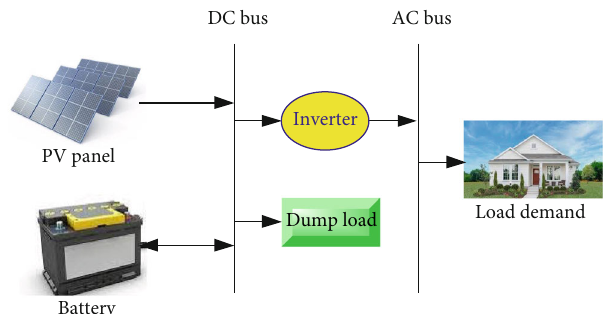
Figure 1: Stand-alone hybrid solar/battery system schematic.